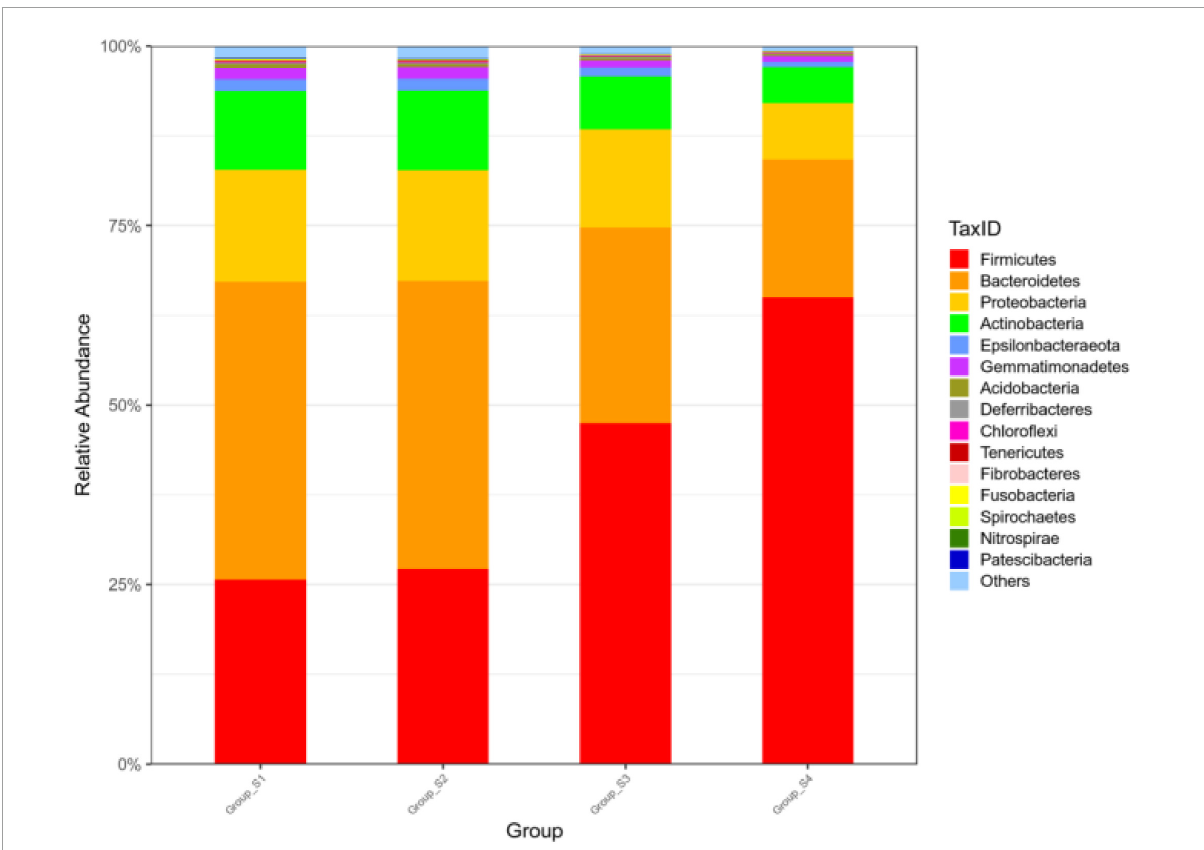
FIGURE1 Relative abundance of bacteria at the phylum level of fermented mutton sausage during natural ripening (the 15 most abundant phyla).